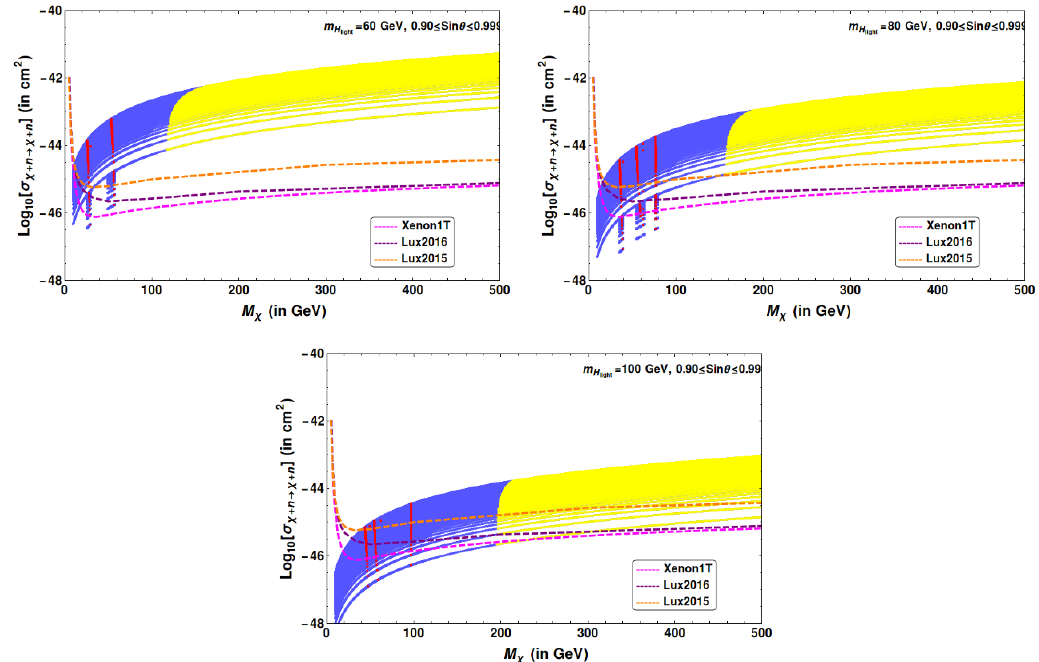
Figure 7 . Spin independent direct search cross section as a function of DM mass M (cid:31) for three di(cid:11)erent choices of m H = 60, 80 and 100 GeV respectively shown in the upper left, right and light bottom panel. In each panel blue patch stands for 0 : 90 (cid:20) sin (cid:18) (cid:20) 0 : 999. Red dots in respective panels satisfy relic density constraints. Bounds from LUX and XENON1T are also shown through dotted/dashed lines. The yellow region corresponds to y > 1 : 0 which may violate the perturba- tive